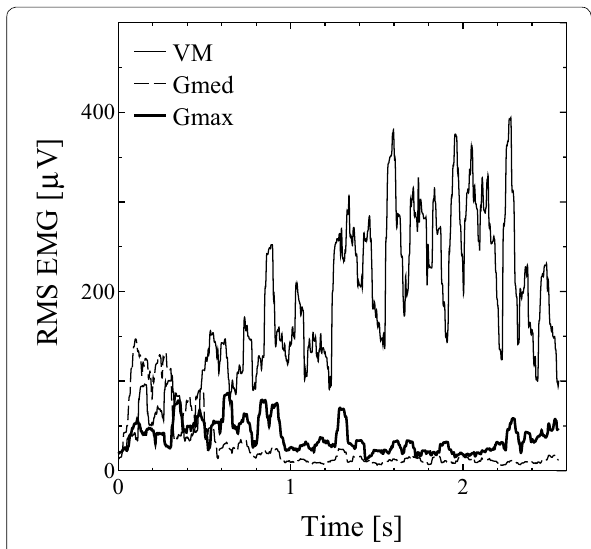
Fig. 26 RMS EMG of a subject with a reconstructed ACL using conventional